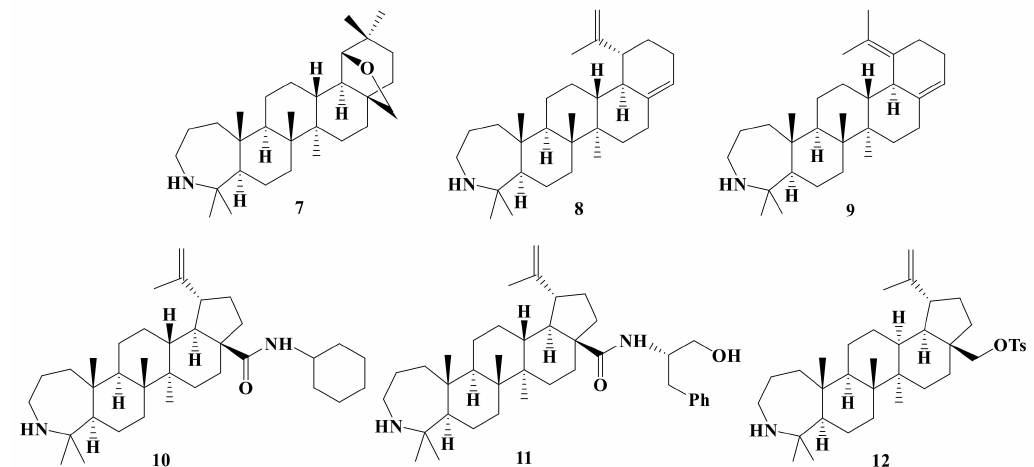
Figure 2. E-ring and C28 azepanobetulin derivatives: Azepanoallobetulin 7 , abeo -lupanes 8 and 9 , amides 10 and 11 , tosylate 12.